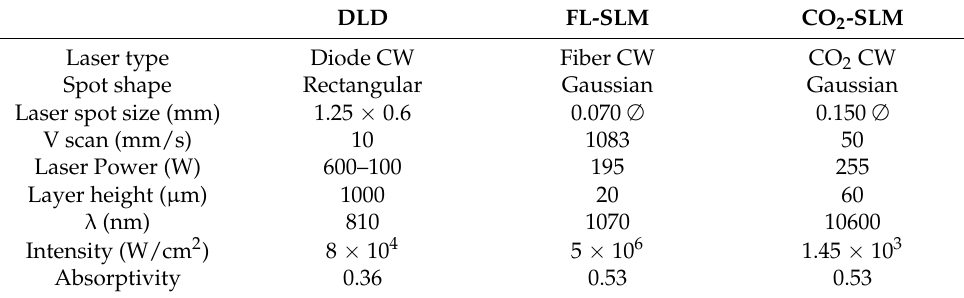
Table 1. Characteristics of the additive manufacturing systems used.